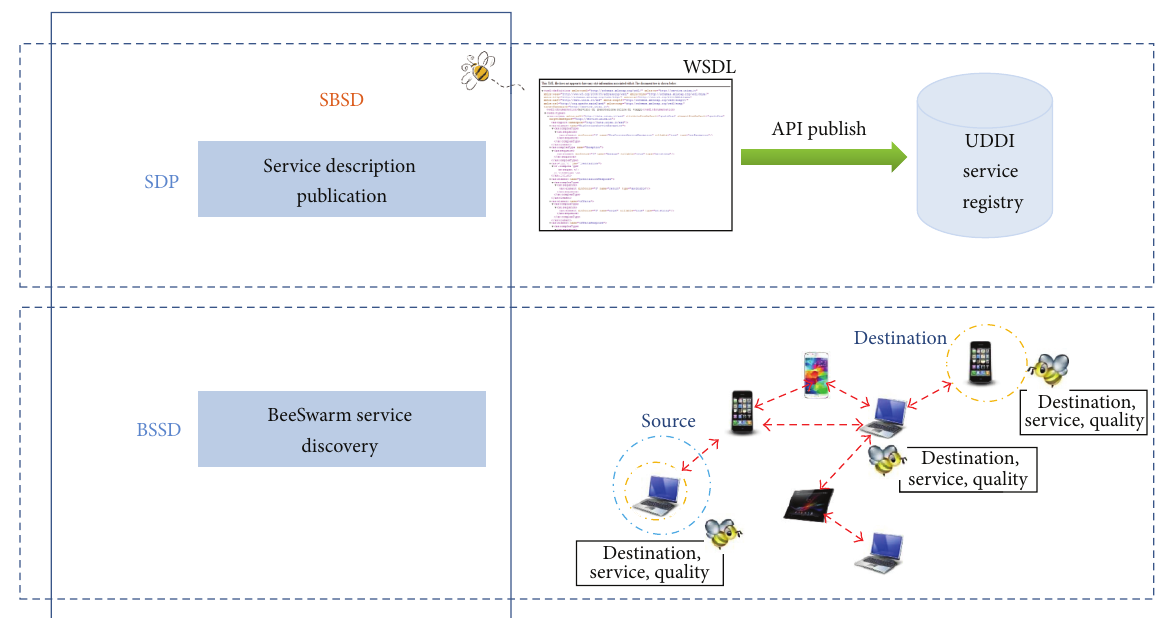
Figure 4: Main components of the SBSD Protocol: the SDP for service publication and the BSSD for service discovery.